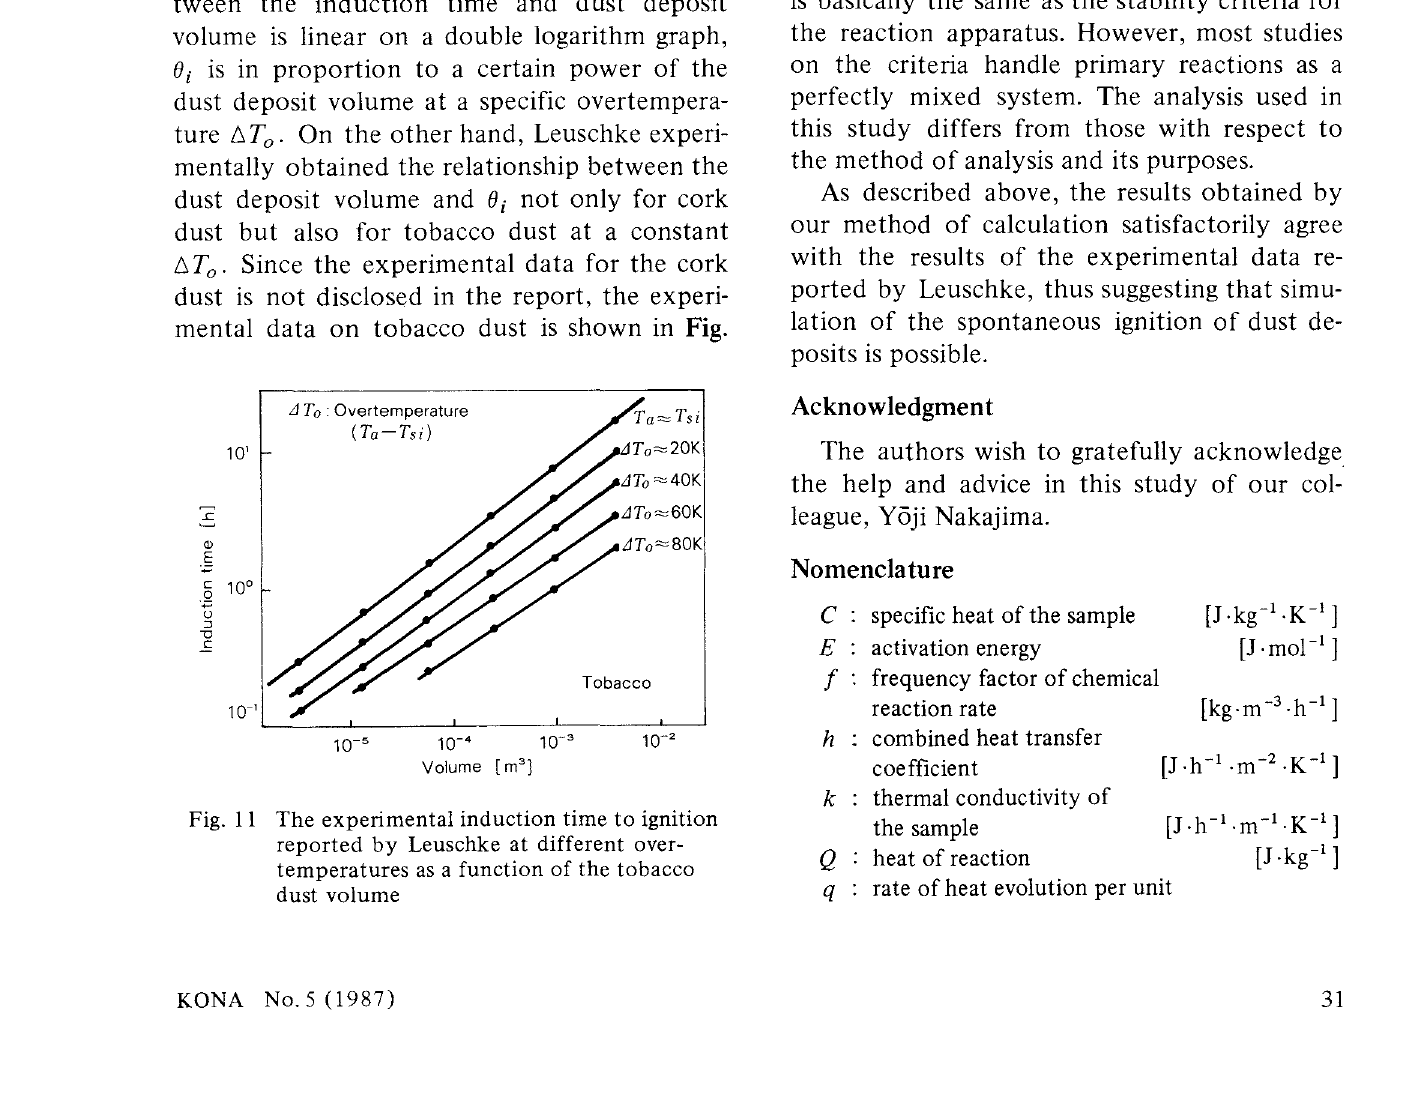
Fig. 10 The induction time to ignition simulated at different overtemperatures as a function of the cork dust volume